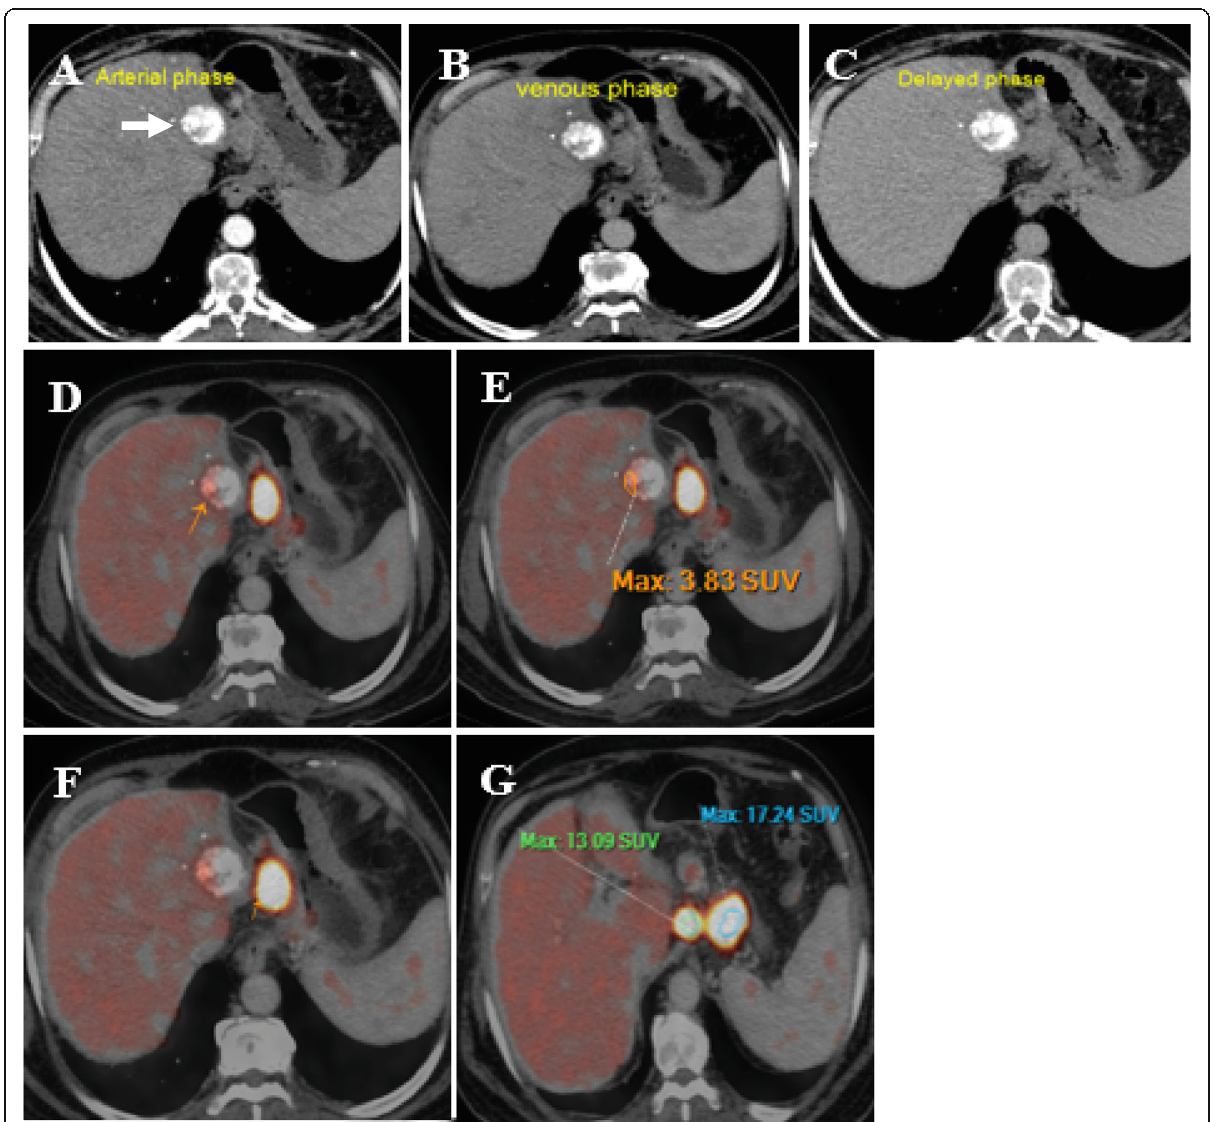
Fig. 2 a – c CECT phases showing lipiodol concentration at chemoembolized lesion at the left lobe with no residual enhancement detected (arrow). d and e Fused PET/CT image showing hyper metabolic focal uptake at the lateral aspect of the chemoembolized lesion (masked by lipiodol at CT)(red arrowed). f and g Axial fused PET/CT images show hypermetabolic metastatic upper abdominal